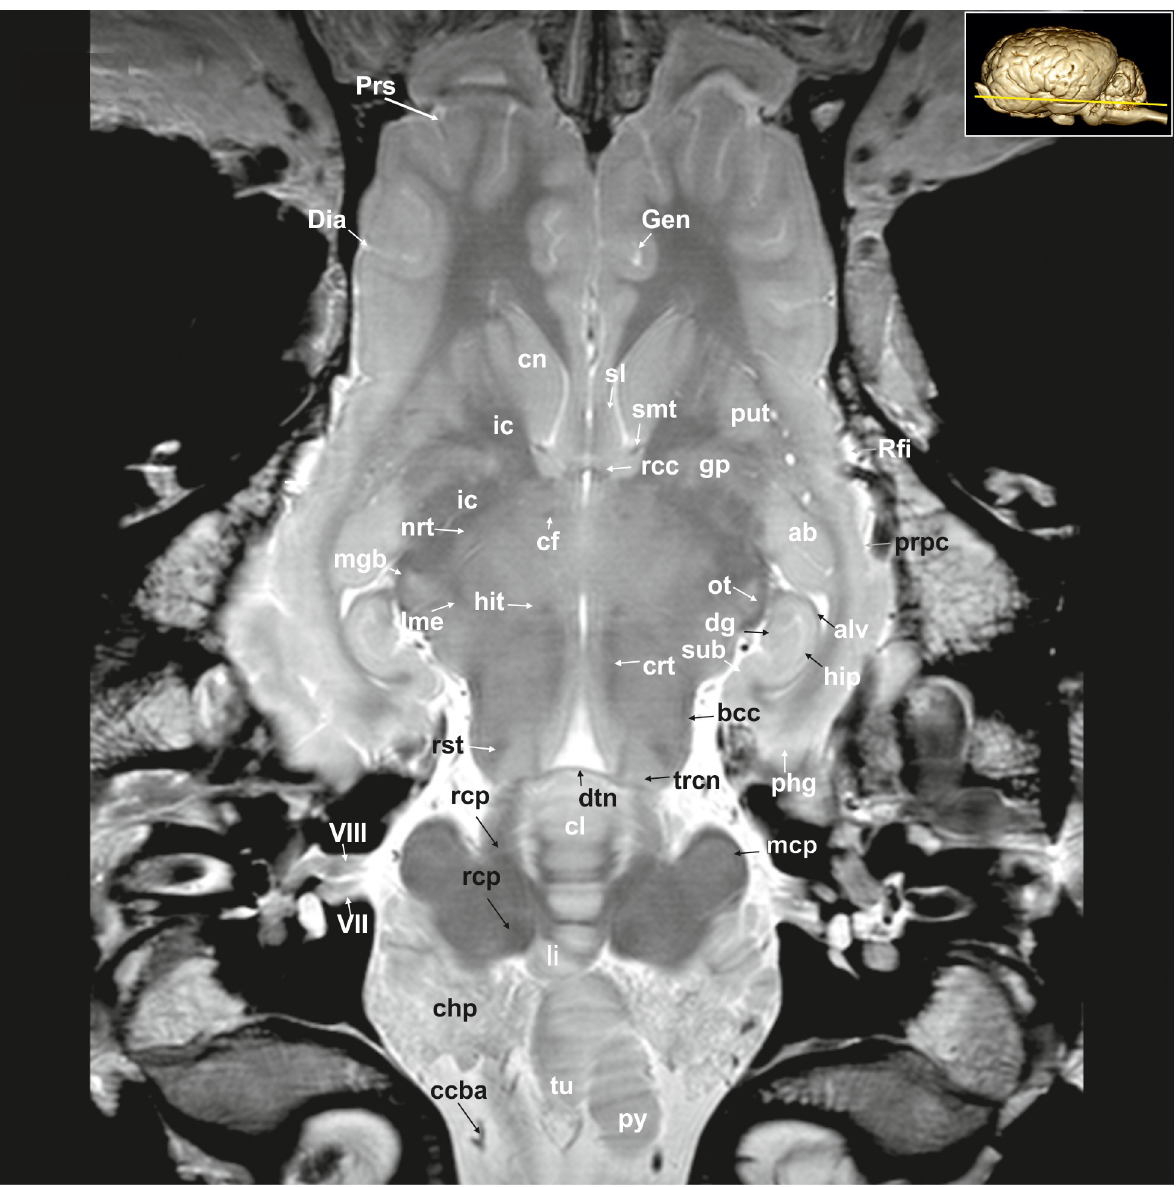
Fig 21. Dorsal magnetic resonance image of the equine brain with visible gyri and sulci. ab: amygdaloid body, alv: alveus, bcc: brachium of the caudal colliculus, ccba: caudal cerebellar artery, cfo: corpus of fornix, chp: choroid plexus, cl: central lobule, cn: caudate nucleus, crt: rubro-cerebello- thalamic tract, df: dentate fascia, Dia: diagonal sulcus, dtn: decussation of trochlear nerve, Gen: genual sulcus, gp: globus pallidus, hip: hippocampus proper, hit: habenulo-interpeduncular tract, ic: internal capsule, li: lingula of the vermis, lme: external medullary lamina, mcp: medial